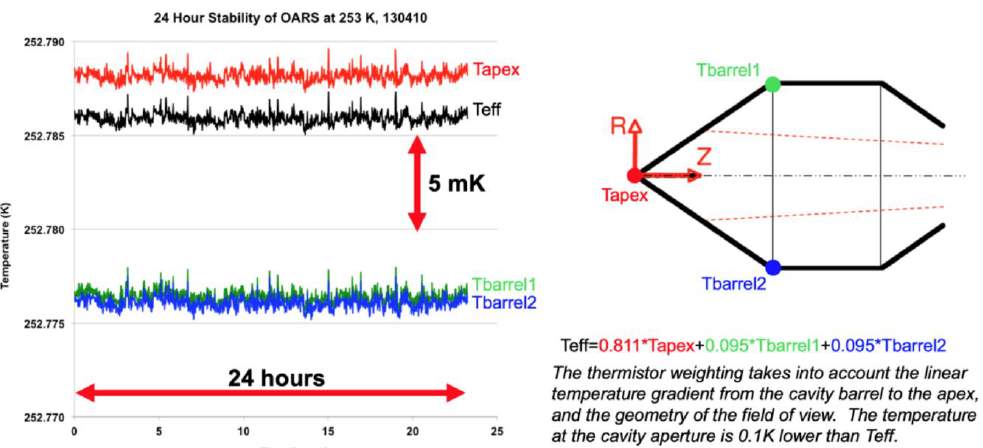
Figure 21. OARS temperature gradients at − 20 ◦ C and 24-h stability in a vacuum environment. The temperature of the ARI instrument and its surroundings is + 20 ◦ C. The red dashed lines in the diagram on the right represent the field of view of the Calibrated Fourier Transform Spectrometer (CFTS) as it observes the